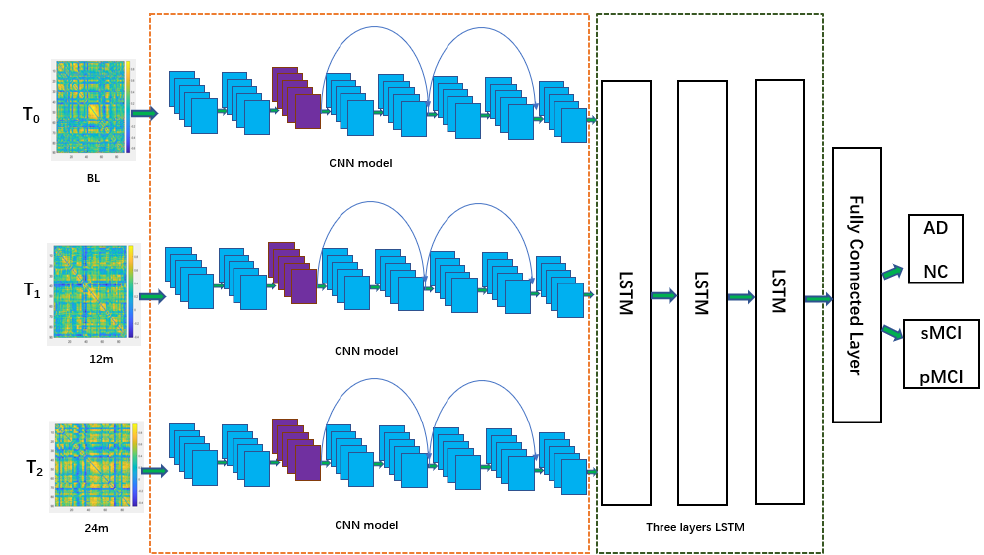
Figure 9. The design of a CNN combined with a three-layer LSTM framework.